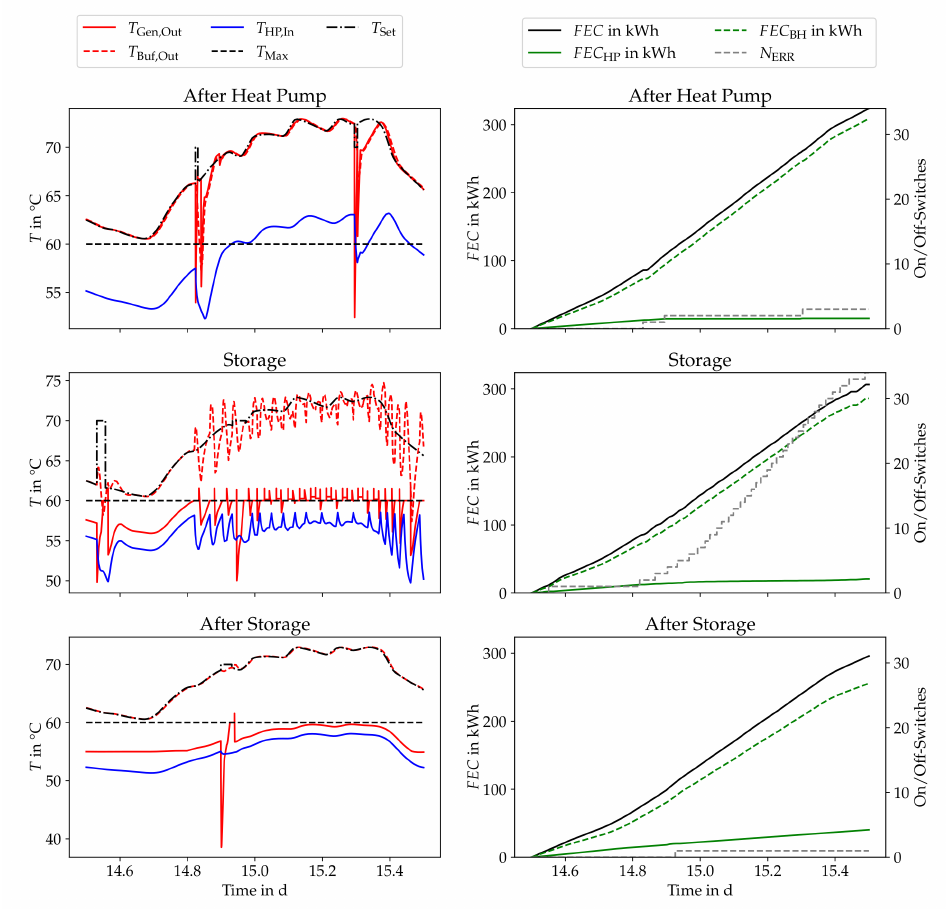
Figure 6. Comparison of the temperature curves for BH placements in non-refurbished buildings, warm weather with high supply temperatures and low operational envelope (Scenario